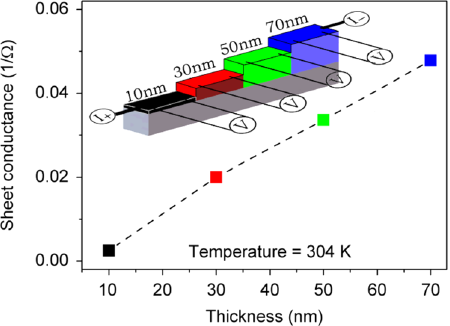
Fig. 3 Maximum sheet conductance as a function of fi lm thickness. The electrolyte is PEG-NaF and the fi lm has been charged at V G = 2.2 V and T = 304 K for 2 h. (Inset) Sketch of a step-like fi lm, deposited using a shadow-mask that is moved in such a way that different portions of the fi lms have different